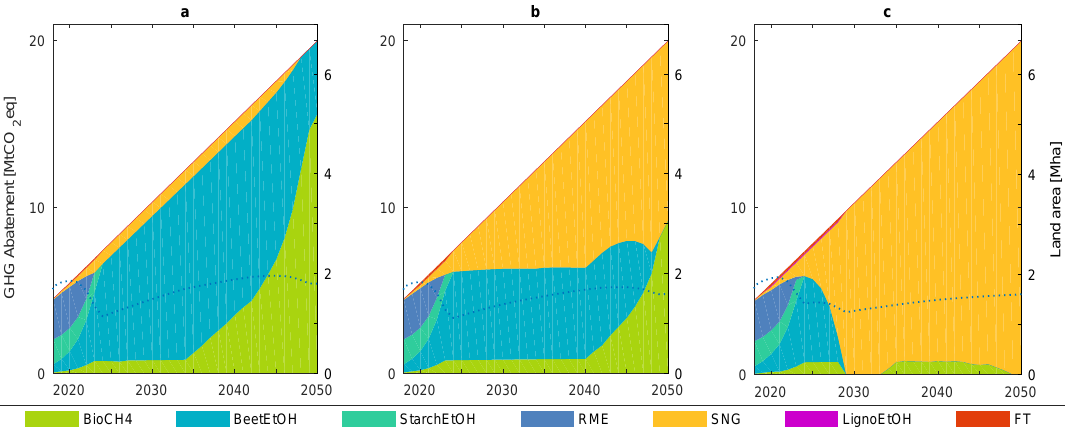
Figure 7. Biofuel competitiveness based on relative GHG abatement cost in the scenarios. The areas show the total performed GHG abatement through each option (left axis), whereas the dotted line shows the total arable land required (right axis). The base scenario ( a ) assumes a moderate power mix development according to ([43], p. 123), a wheat price increase of 4% a − 1 , GHG optimized process heat and medium yields for all crops. In Scenario ( b ), the power mix is more progressive, and in Scenario ( c ), additionally, the sugar beet and silage maize yields are assumed within the low range in Table